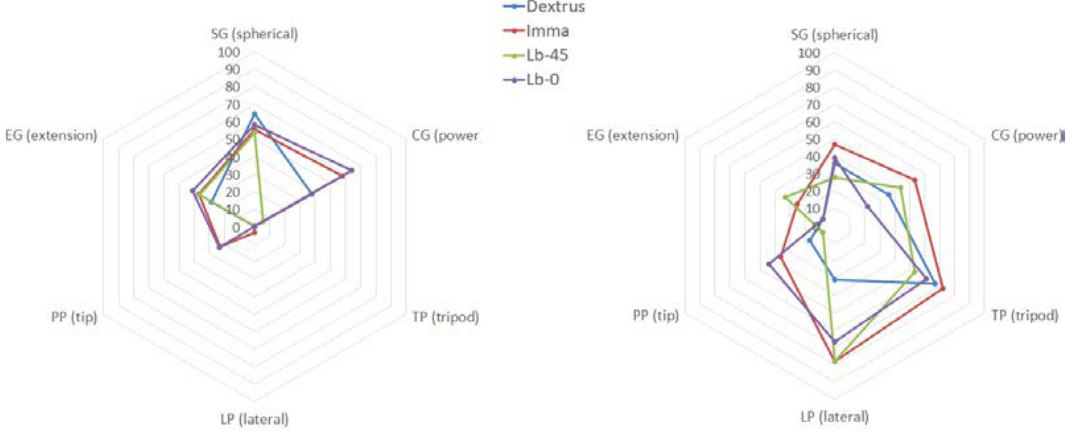
Figure 10. Left, Ts scores across the various prehensile patterns of the SHAP; right, AHAP’s pGAS for those same patterns.